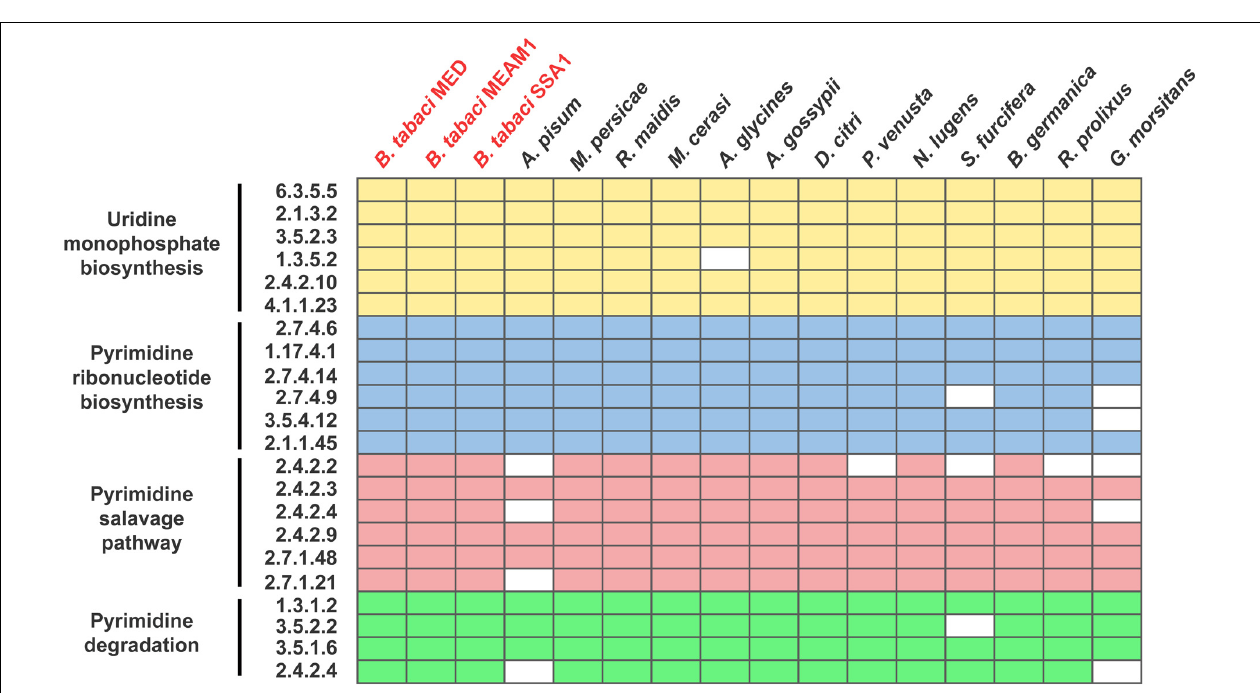
FIGURE 2 | Content of genes involved in the pyrimidine pathway of host insects. The boxes representing genes involved in uridine monophosphate biosynthesis are colored yellow; pyrimidine ribonucleotide biosynthesis, blue; the pyrimidine salvage pathway, red; and pyrimidine degradation, green. Biosynthetic processes are shown in their linear order. The EC number of each gene is also shown. B. tabaci is colored red. Detailed information on the select insects is listed in Supplementary Table 2